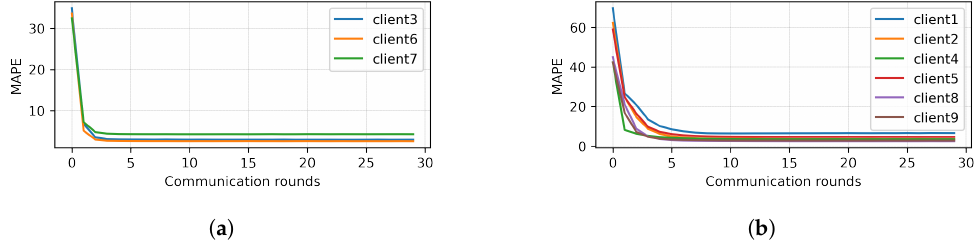
Figure 11. FL results of second round of clustering after 30 communication rounds. ( a ) FL results when Branch 2 + 4. ( b ) FL result of Branch